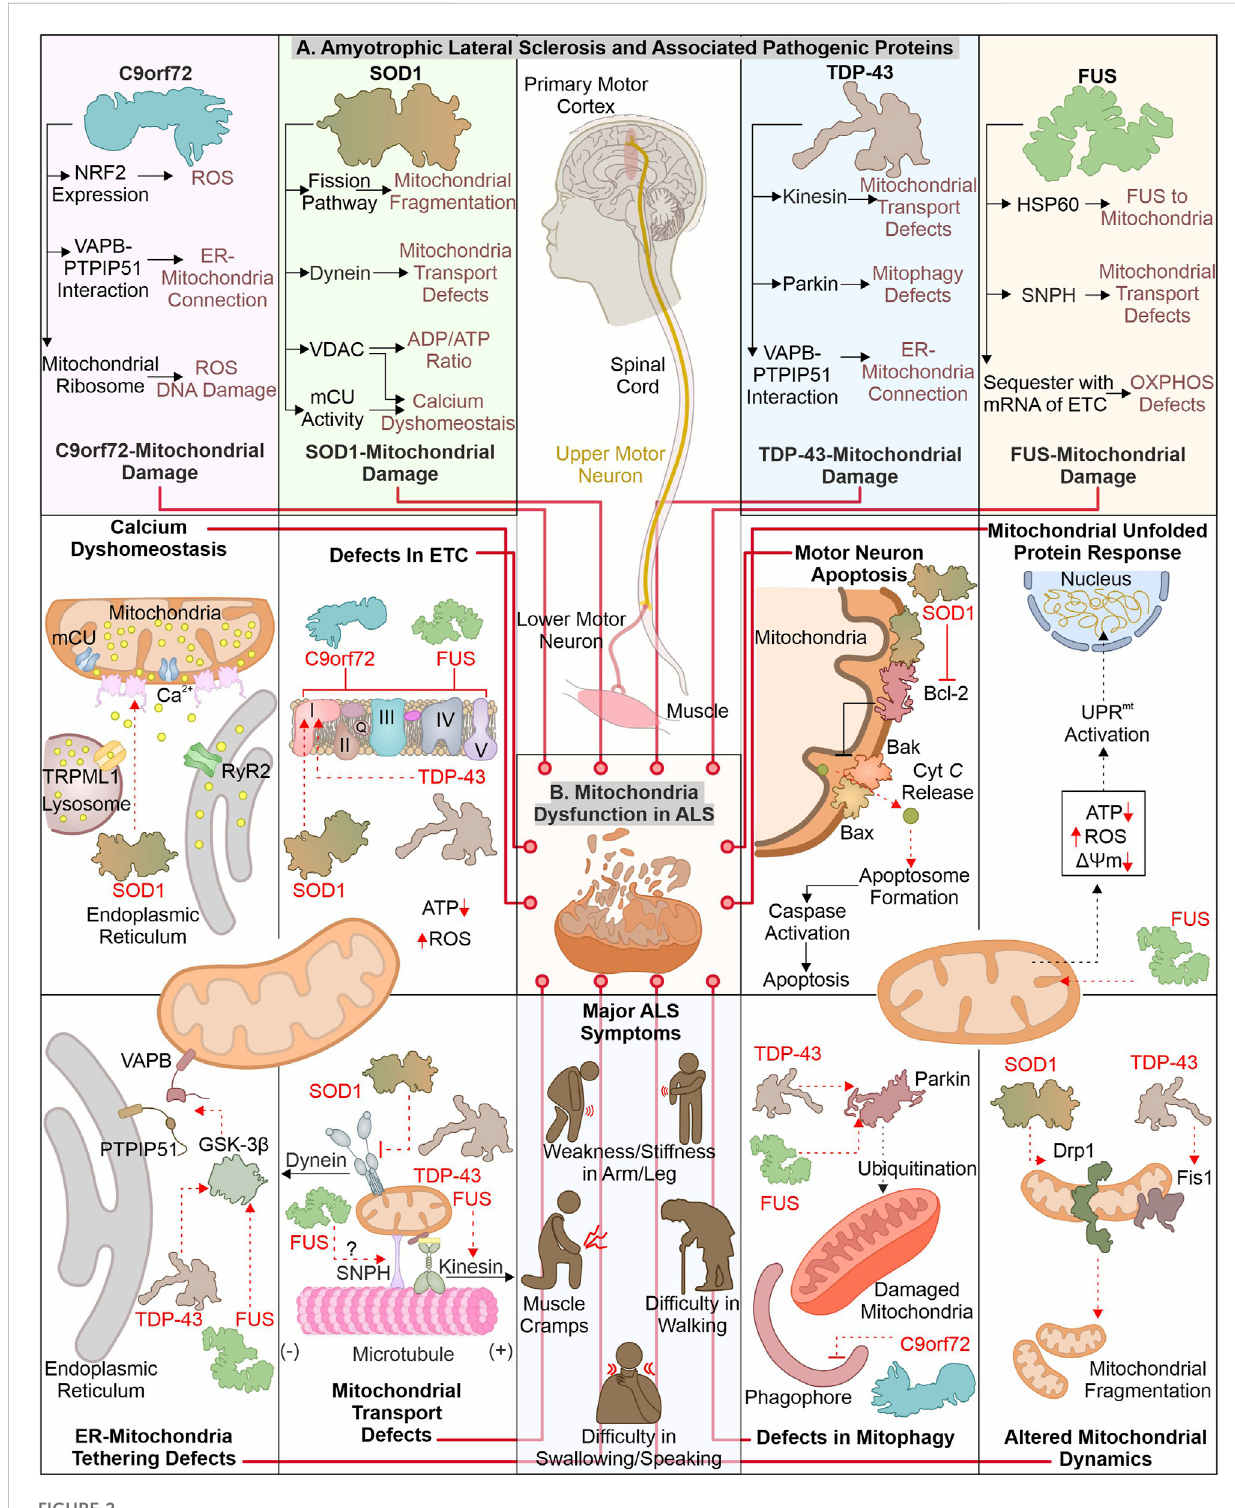
FIGURE 2 ALS-linkedmutantproteinscontributetomitochondrialimpairment.ALSisacomplexneuronaldegenerativeconditionwheremotorneurons(brain and spinal cord) are affected. Various signs, like muscle cramps, stiffness in the arm, and swallowing and speaking dif fi culties, characterize ALS patients. Different disease-causing proteins are identi fi ed to interact and affect mitochondrial proteins causing mitochondrial damage at several levels (A). The interaction of ALS-linked pathogenic proteins (TDP-43, SOD1, C9orf72,and FUS) with mitochondria and associated proteins causes its dysfunction, leading to calcium dyshomeostasis, altered OXPHOS, mitochondrial dynamics, and mitophagy (B)